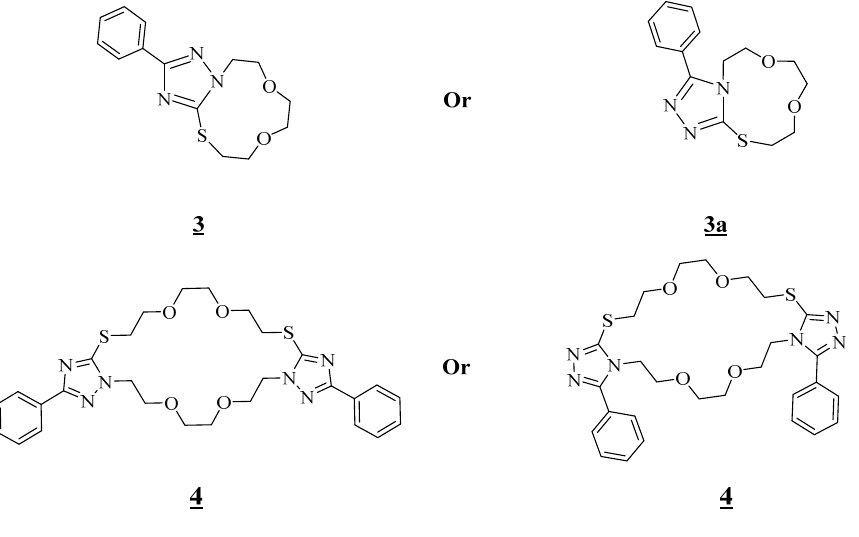
Figure 2. Possible isomeric forms of 3 and 4